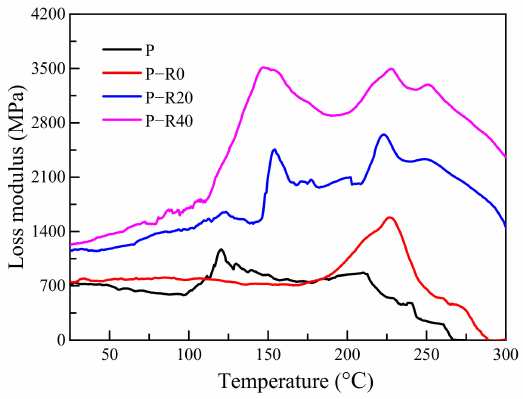
Figure 5. Loss modulus of control and modified wood